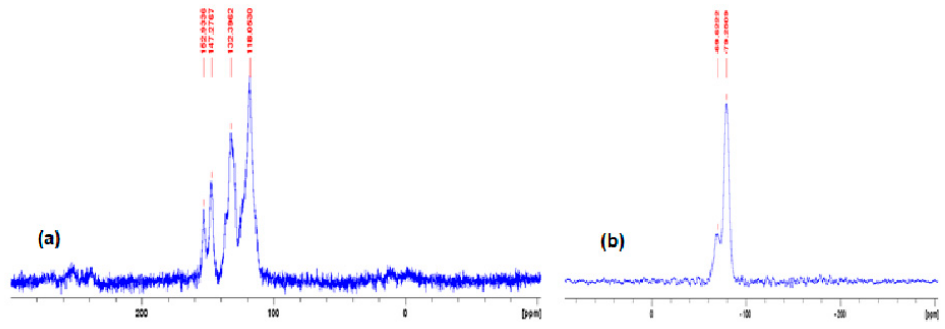
Figure 5. ( a ) CP-MAS 13 C solid-state NMR spectra of OAPS ( b ) CP-MAS 29 Si solid-state NMR spectra of OAPS.